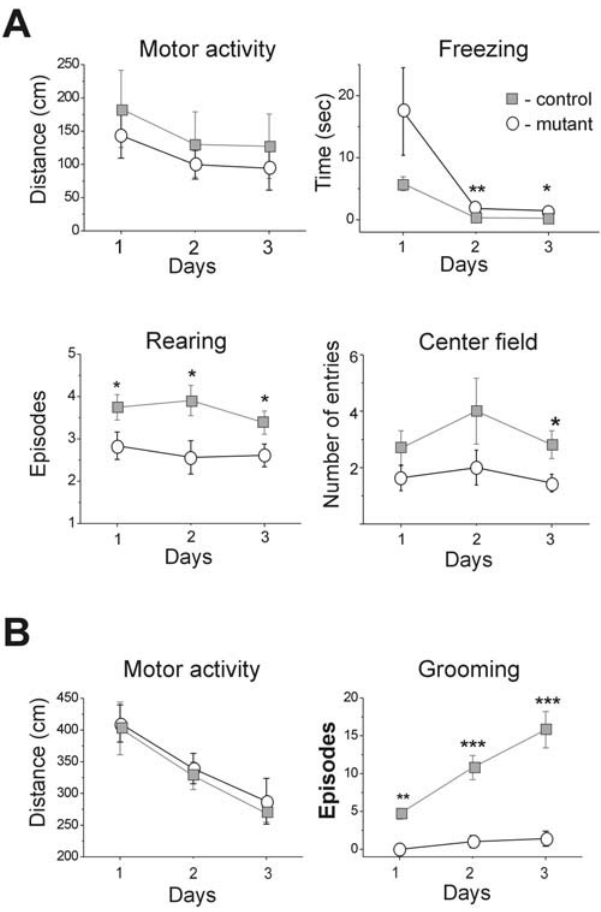
Figure 8. Mutant mice differed from their controls in stress related aspects of exploratory behavior. (A) Control mice (n=16,) were compared to mutant mice (n=11, open circles) in the Open-Field test. The general motor activity was measured as the total distance traveled during the test. The Freezing was measured as the latency to escape from the center of the field. Rearing and entries to the center of the field episodes were counted. (B) Example parameters from the results of the Hole-Board test are displayed. The motor activity is measured as the total distance traveled during the test. Grooming episodes are counted (control-n=6, gray closed squares controls; mutants-n=9, open circles). For all tests, data is displayed as mean 6 S.E.M. Significant difference between the groups on a specific day are marked: *-p # 0.05; **-p # 0.01; ***-p # 0.001.